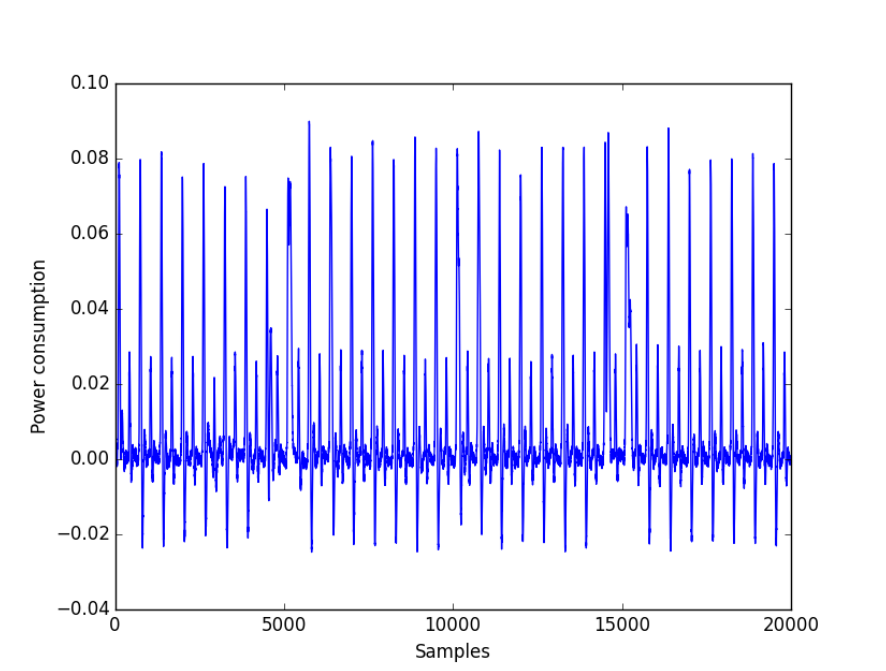
Figure 9: One trace of DES leakage (from DPA contest v1 [TEL09])